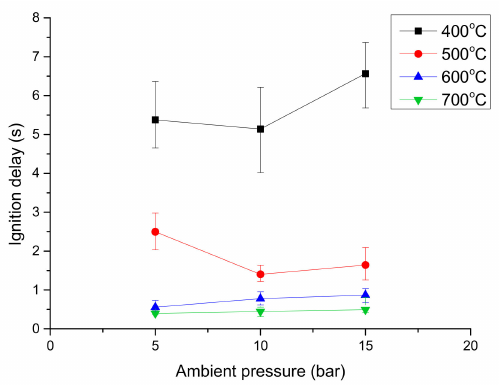
Figure 13. Ignition delay of an emulsion droplet at various ambient temperatures and